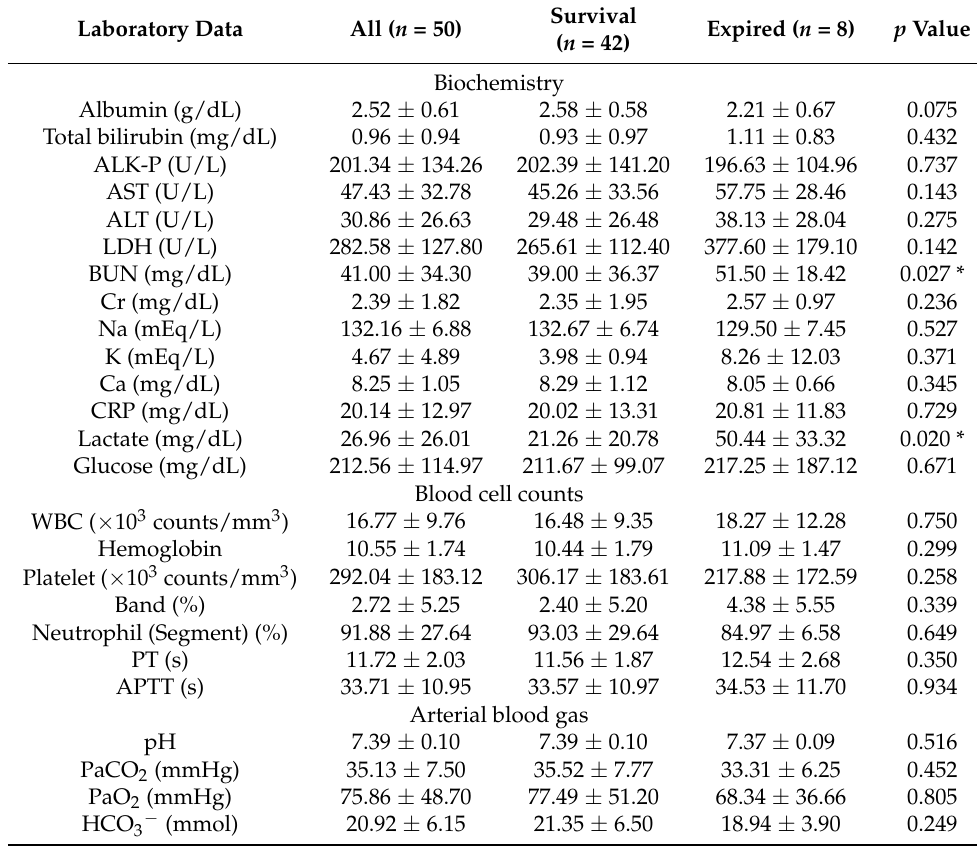
Table 2. Laboratory data of EPN.